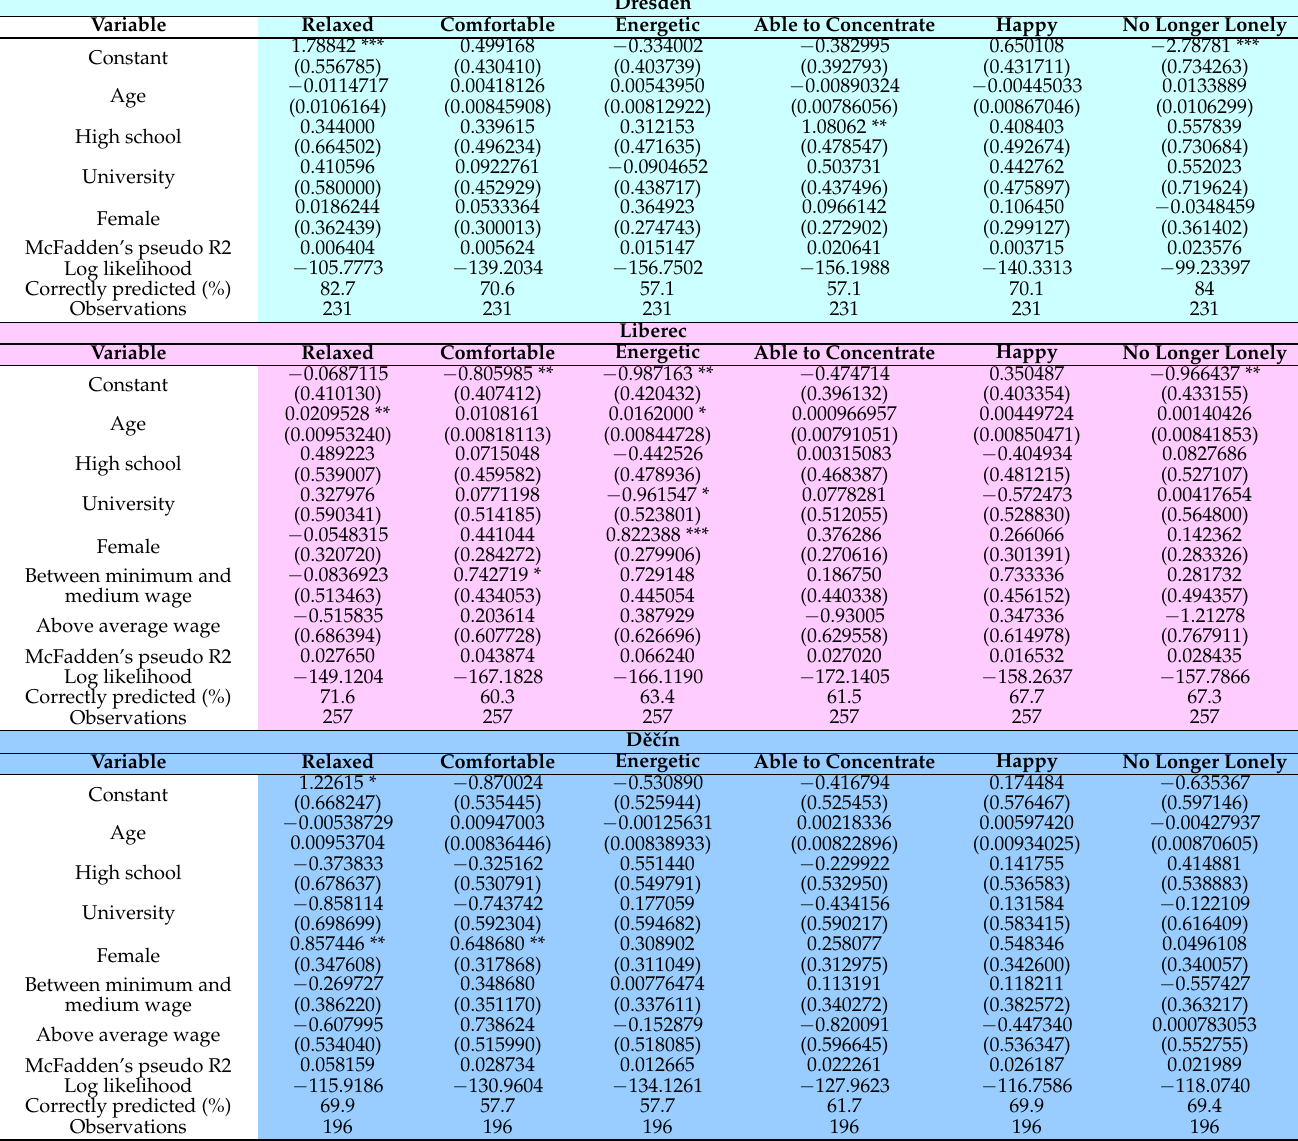
Table 3. Dependence of reported feelings on selected socio-demographic